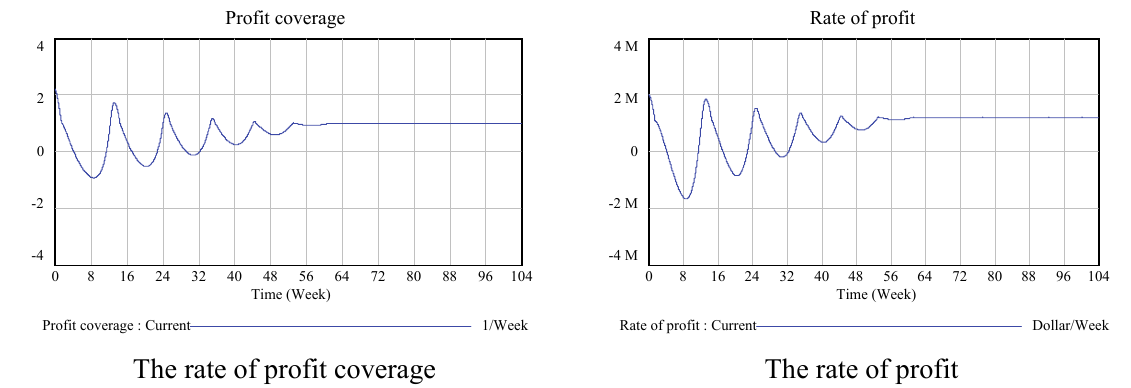
Fig. 10. The trend on profit coverage and